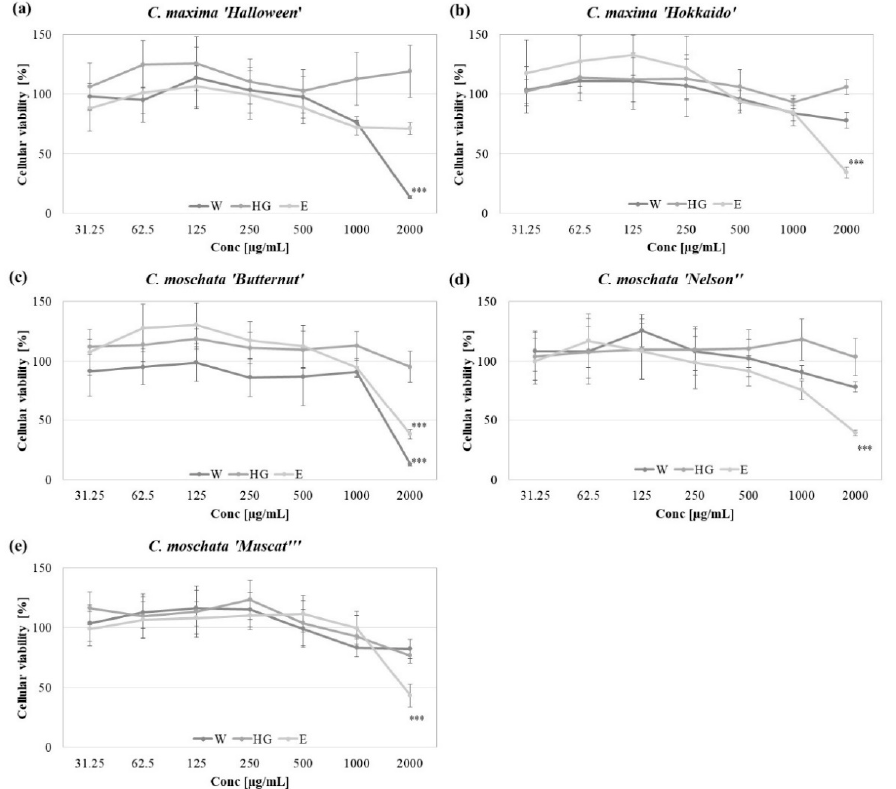
Figure 2. In vitro cytotoxicity of W (aqueous), HG (hydroglycolic) and E (ethanolic) extracts from the C. maxima “Halloween” ( a ), and ‘Hokkaido” ( b ), C. moschata ‘Butternut’ ( c ), ‘Nelson’ ( d ) and ‘Muscat’ ( e ) cultivar peel extracts on human keratinocytes HaCaT, following 48 h culture; graphs show